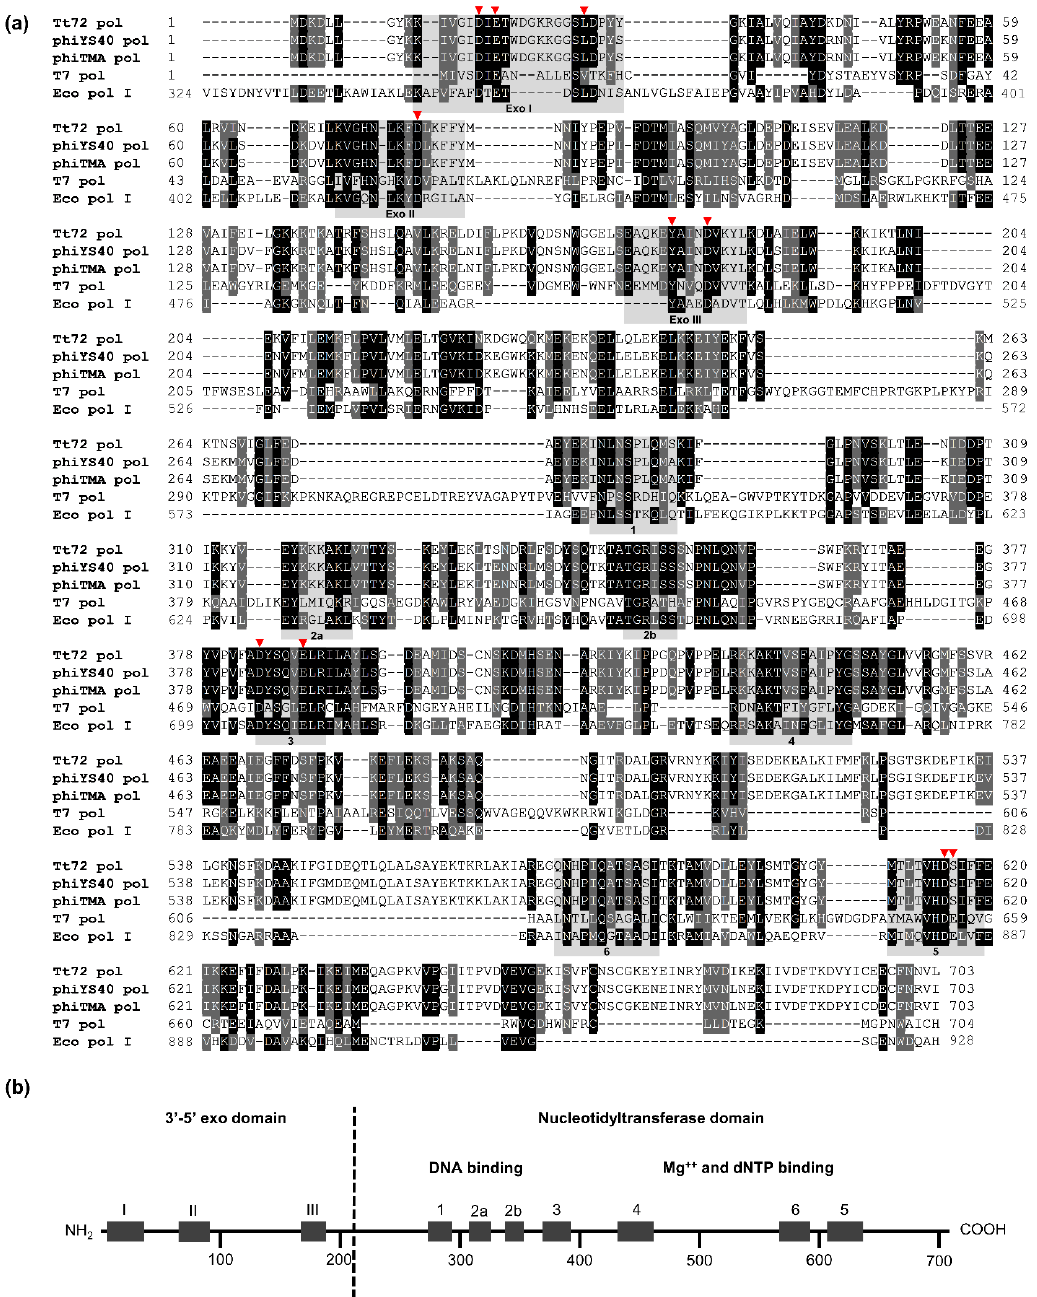
Figure 1. ( a ) Multiple sequence alignment of the Tt72 pol and its type-A family homologs. The alignment was performed using CLUSTAL W. The GenBank accession numbers for the genes coding for Tt72, φ YS40, φ TMA, T7, and E. coli (Pol I) DNA polymerases ON714139, YP_874046.1, YP_004782240.1, NP_041982.1, WP_000250029.1, respectively. Gray shading reflects amino acid conservation at 70% consensus, whereas the black boxes represent 100% amino acid sequence identity. The highly-conserved amino acid motifs within the 3 ′ - 5′ exo (Exo I, Exo II, and Exo III) and the nucleotidyltransferase domain (1, 2a, 2b, 3, 4, 5, and 6) are indicated. ( b ) Modular organization of Tt72 pol. The product polA gene of phage vB_Tt72 is a protein composed of a 703 amino acid with a 3 ′ -5 ′ exo and nucleotidyltransferase domain. The positions of motifs characteristic for both domains are indicated. The red triangle indicates the catalytic residues within the 3′ - 5′ exo and nucleotidyltransferase domain, wherein the importance was verified using site-directed mutagenesis.